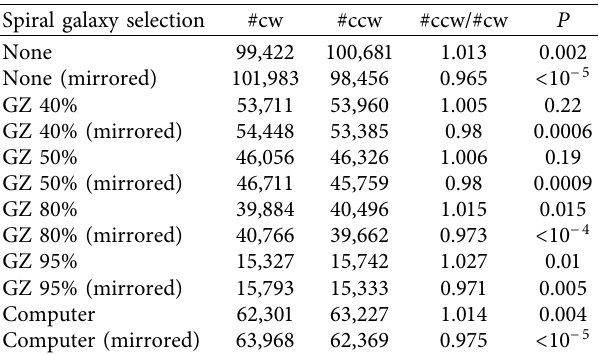
Table 5: Te distribution of galaxy spin directions in the hemi- sphere ( 120 o < α < 330 o ) . Te analysis is carried out by applying the SpArcFiRe algorithm after selecting spiral galaxies using Galaxy Zoo (GZ) annotations and computer annotations and by applying SpArcFiRe with no selection of spiral galaxies at all. Spiral galaxy selection